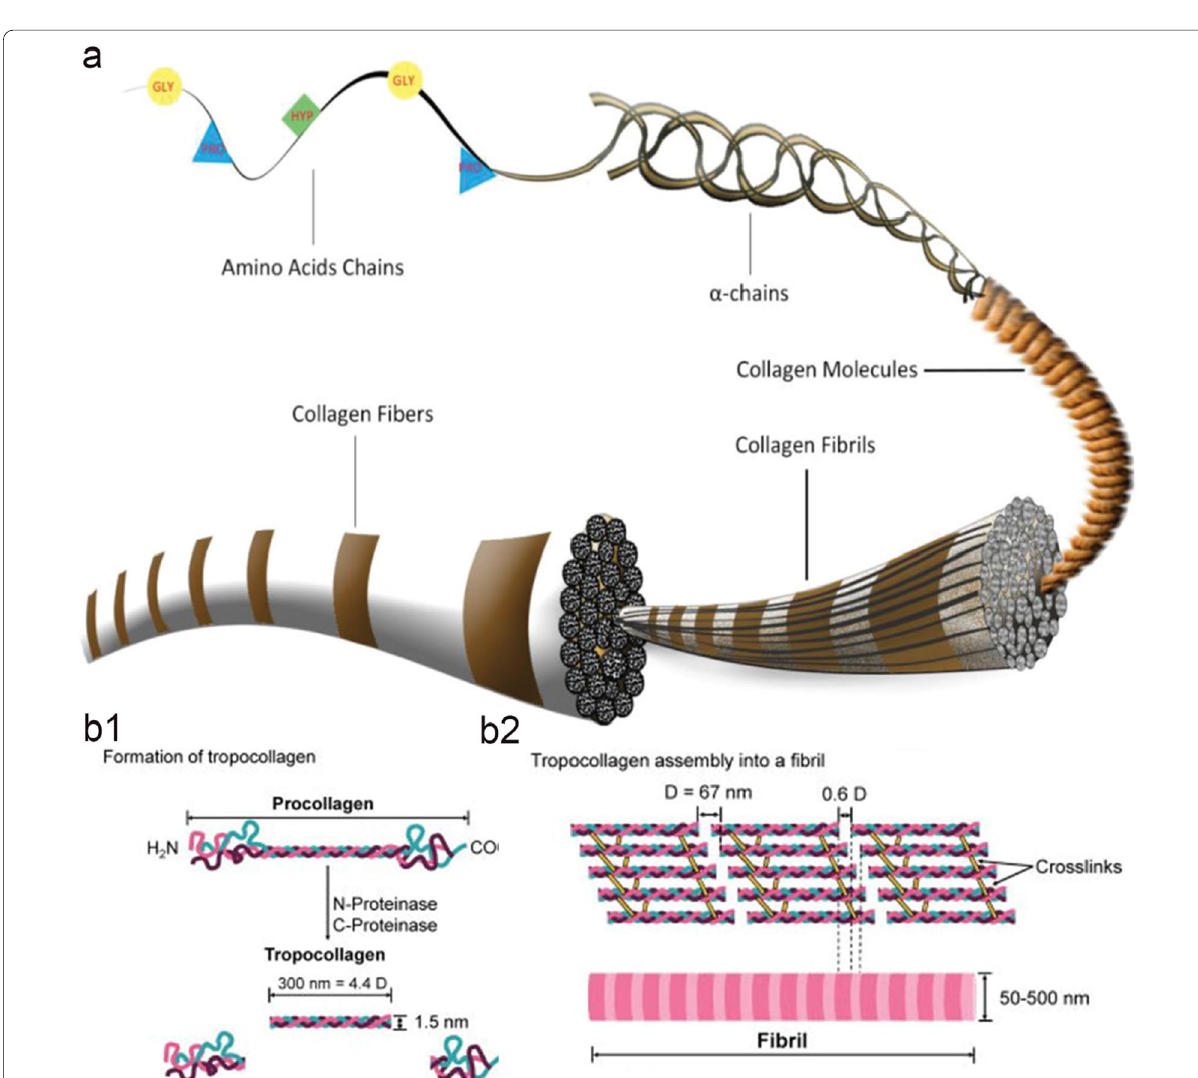
Fig. 1 Structure of collagen. a The four-dimensional structure of collagen fibers. Reproduced with permission from[2]; b1, b2 Molecular structure and synthesis of collagen I. Following intracellular post translational modifications, three polypeptide chains assemble into procollagen ( b1 ), which is then exocytosed into the extracellular space. Collagen I tropocollagen is 300 nm (corresponding to 4.4 D) in length and 1.5 nm in diameter ( b2 ). Reproduced with permission from